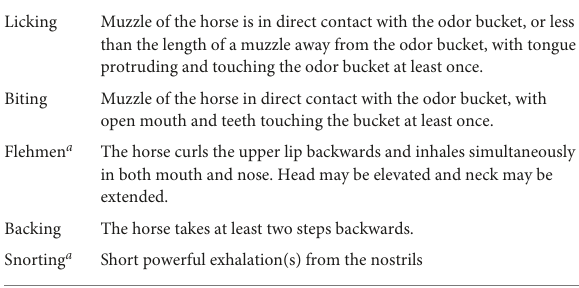
TABLE 1 Odor presentation order with 1st, 2nd, 3rd and 4th odor O = orange, P = peppermint, C = cedar wood, L = lavender.